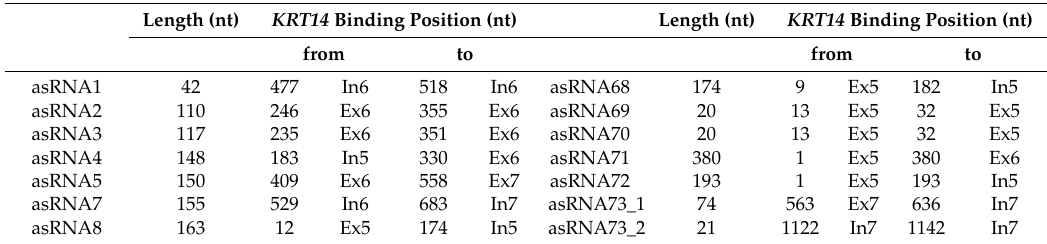
Figure 3. Functional analysis of selected asRNAs. ( A ) Binding position of sequence-analysed individual asRNAs, expressed from the pcDNA 4.0 plasmid, within the KRT14 target region spanning from exon 5 to intron 7; ( B ) flow cytometric analysis of HEK293 cells upon triple-transfection with the KRT14 -scRTM, the KRT14 -scMG and individual asRNAs increased the trans -splicing efficiency in comparison to that detectable in HEK293 cells transfected with the screening molecules and an empty (without asRNA sequence) pcDNA4.0 expression plasmid in all transfection experiments. The level of accurate trans -splicing was quantified by flow cytometric counting of GFP-expressing cells two days post treatment and referred to the pcDNA4.0 control (set to 1). Two independent transfection experiments (HEK1 and HEK2) are shown. Table 1. Randomly generated